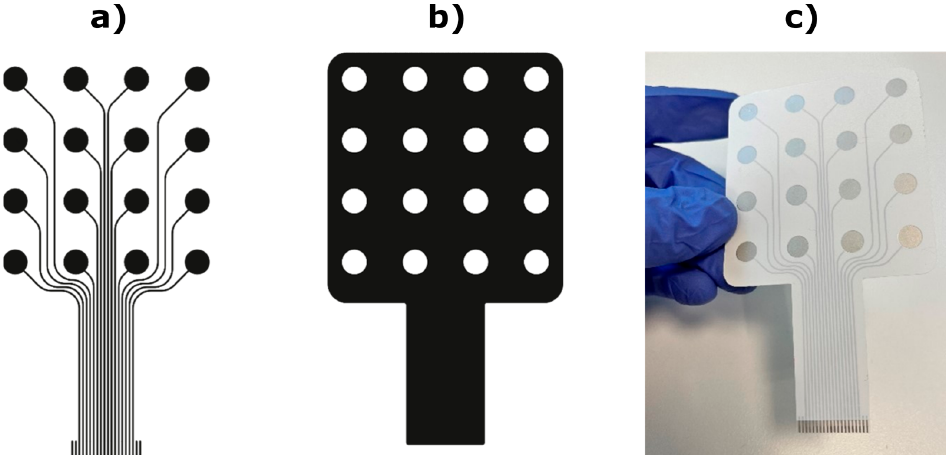
Figure 4. Design of the printed flexible PET electrode. ( a ) Design of the silver electrode pads with leads. ( b ) Design of the dielectric protective layer. ( c ) Printed flexible electrode.